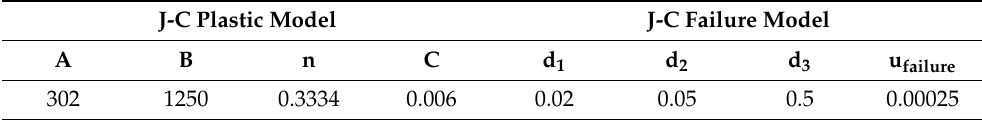
Table 3. Material constants in J-C material model for 1.3964 steel [63,65].